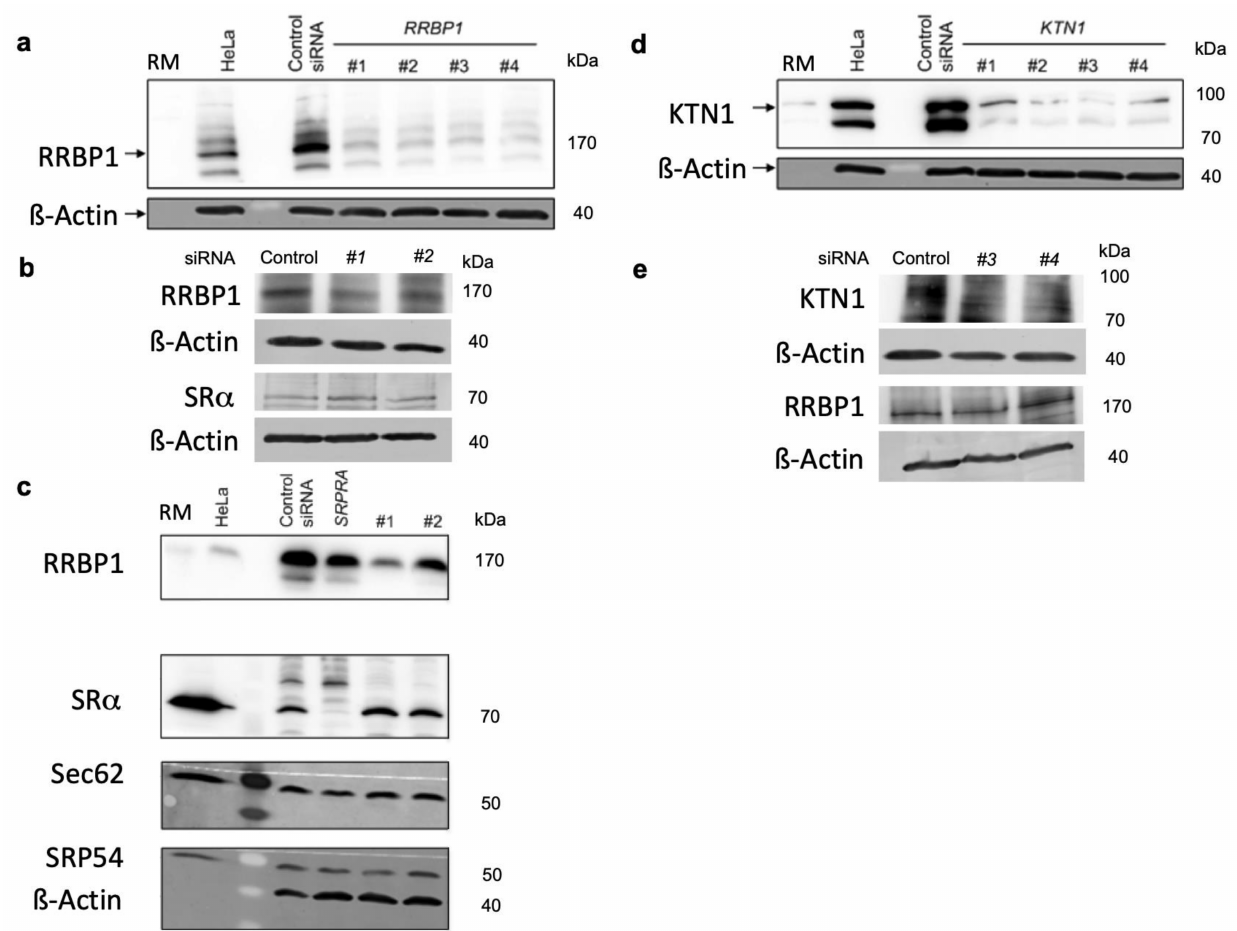
Figure 4. Western blots after RRBP1 or KTN1 depletion. ( a , d ) Depletion of RRBP1 or KTN1 was carried out in HeLa cells using four different targeting siRNAs against each target (#1–#4) in comparison to a non-targeting siRNA (control siRNA) for 96 h. Knock-down efficiencies were evaluated by western blot. For the following MS experiments siRNAs #1 and #2 were chosen for depletion of RRBP1 ( a ), siRNAs #3 and #4 for KTN1 depletion ( d ). ( b , e ) MS data after depletion of RRBP1 or KTN1 were evaluated with respect to positively affected proteins by western blots. ( c ) Furthermore, MS data after depletion of RRBP1 were evaluated with respect to positively affected and unaffected proteins, respectively, by western blots. ( a – e ) Molecular mass values are indicated in kilodaltons (KDa). Only the area of interest of the blots is shown. RM, canine pancreatic rough microsomes, which were used for antigen identification. SR α was depleted from HeLa cells by siRNA treatment as an additional control